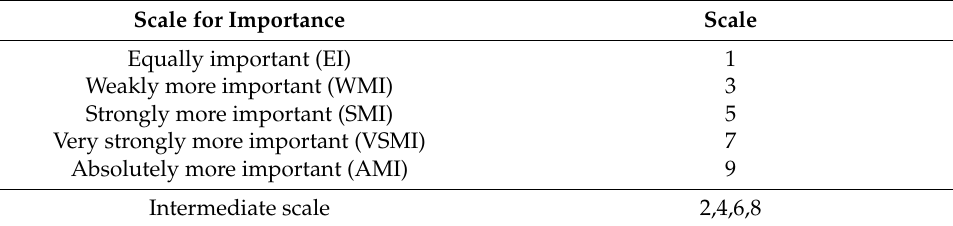
Table 4. Conventional Saaty’s scale used in the AHP method [24].